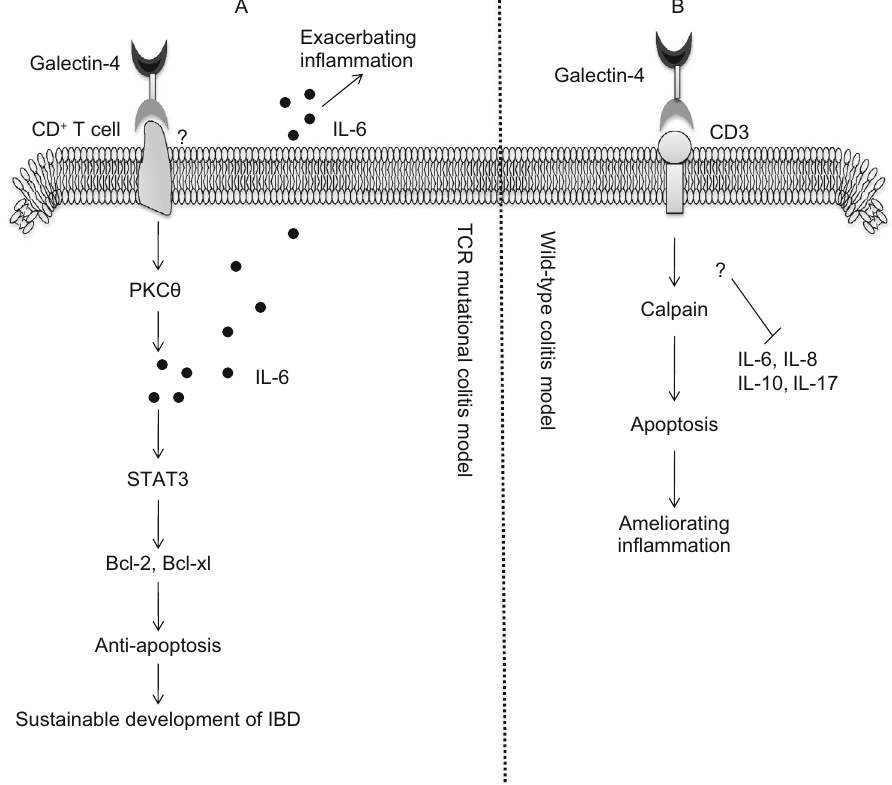
Figure 3. The different molecular mechanism of galectin-4 in exacerbating or ameliorating in fl ammation. (A) (Exacerbating in fl ammation): Through binding to the receptor (may be CAG) expressed by CD4 + Tcells, galectin-4 stimulates the production of IL-6 on TCR mutational colitis model. IL-6 could directly exacerbate IBD and inhibiting the apoptosis of CD4 + Tcells by activating STAT3 pathway, which eventually leading to sustainable development of IBD. (B) (Ameliorating in fl ammation): Galectin-4 ameliorates IBD through inducing apoptosis of T cell and reducing the secretion of in fl ammatory cytokines (IL-6, IL-8, IL-10, and IL-17) on wild-type colitis